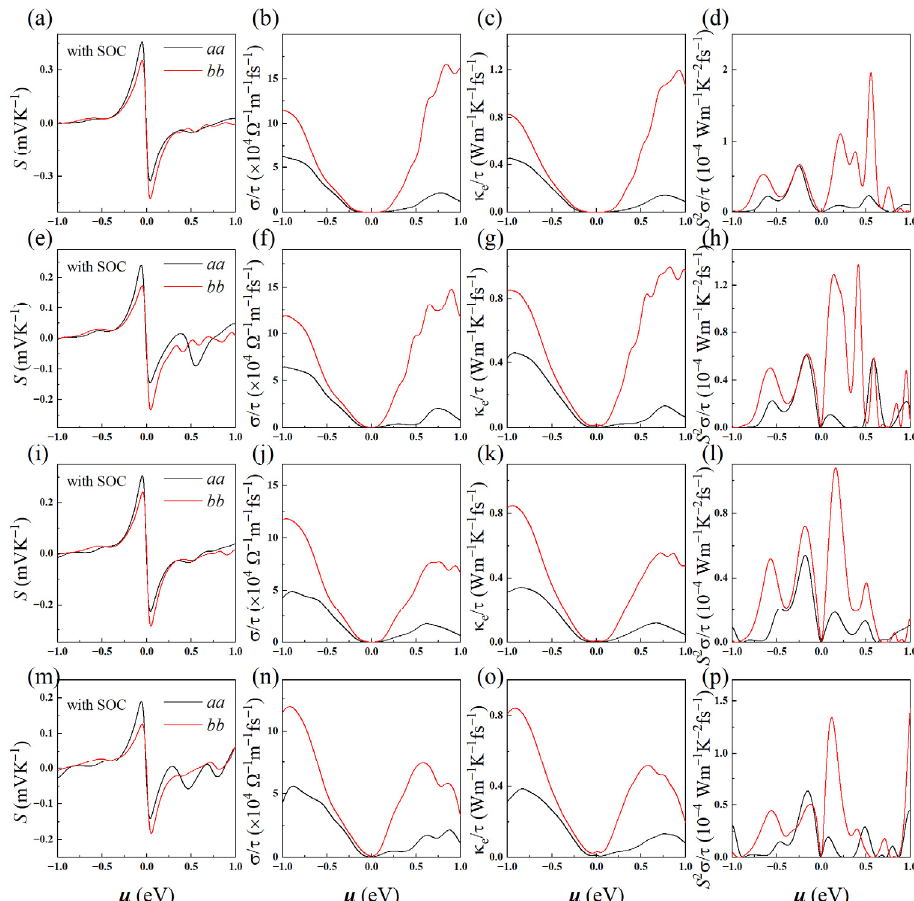
Figure 4. Electron transport properties of 2D CuMN 2 (M = Sb, Bi; N = S, Se): ( a , e , i , m ) Seebeck coeffi- cients; ( b , f , j , n ) electrical conductivities; ( c , g , k , o ) electron thermal conductivities; and ( d , h , l , p ) power factors along a —(black line) and b —directions (red line) with PBE + SOC